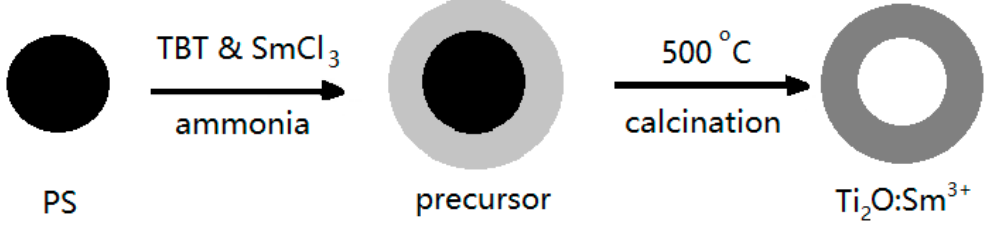
Figure 2. Schematic illustration of the formation mechanism for hollow TiO 2 :Sm 3+ spheres [29].